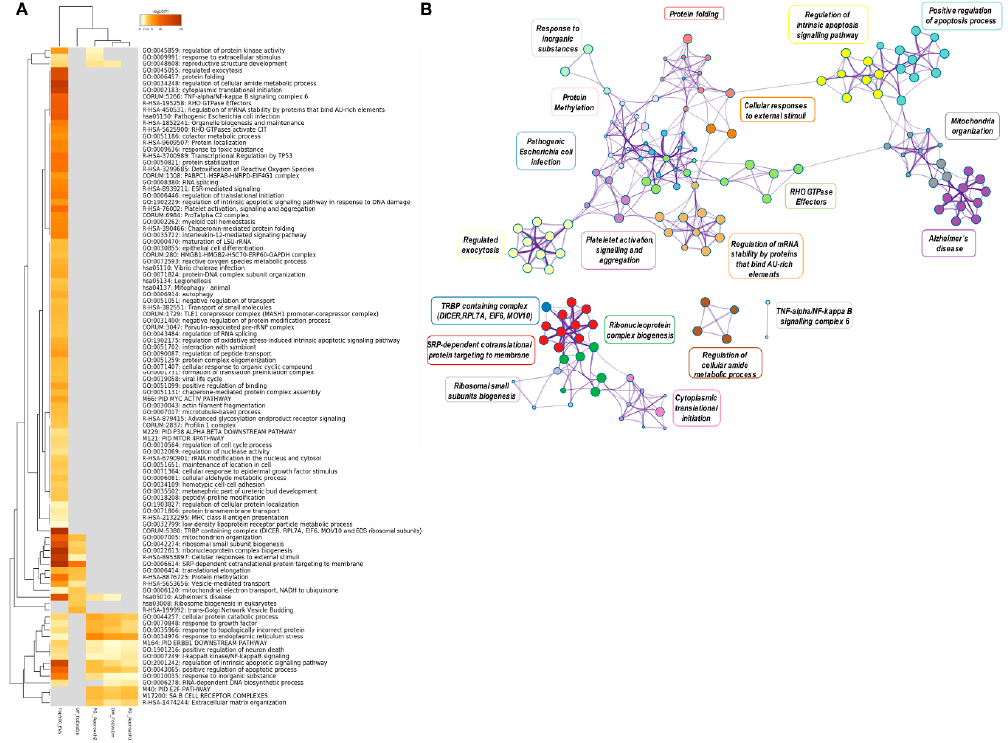
Figure 8. ( A ) Metascape heatmap of enriched terms across input gene lists representing the top 100 functional clusters: (1) the top 500 mRNAs in oEVs, (2) the upregulated genes in FoEV treatment vs. Co, (3) the downregulated genes in FoEV-treated vs. Co embryos, (4) the potential genes targeted by miRNAs in oEVs based on Approach 1 from the identified downregulated genes, and (5) based on Approach 2 from identified miRNAs in oEVs, all colored by p -values. ( B ) Metascape network of enriched terms and protein–protein interaction enrichment analysis of the same input lists.